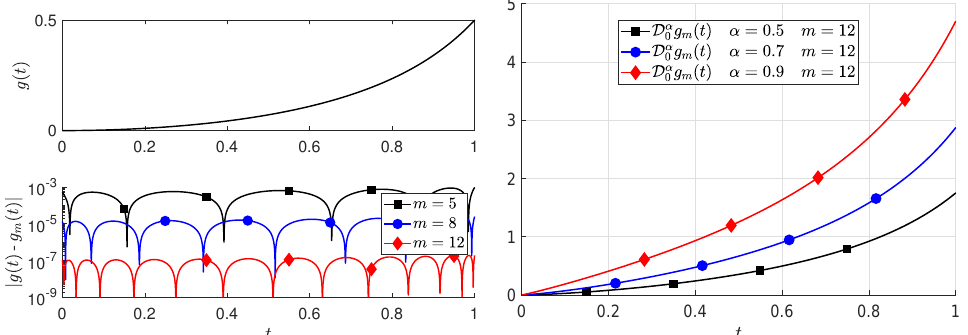
Figure 2. Function g ( t ) and errors of truncated approximations g m ( t ) ( left plot). RL derivatives D α g m ( x ) for m = 12 ( right 0